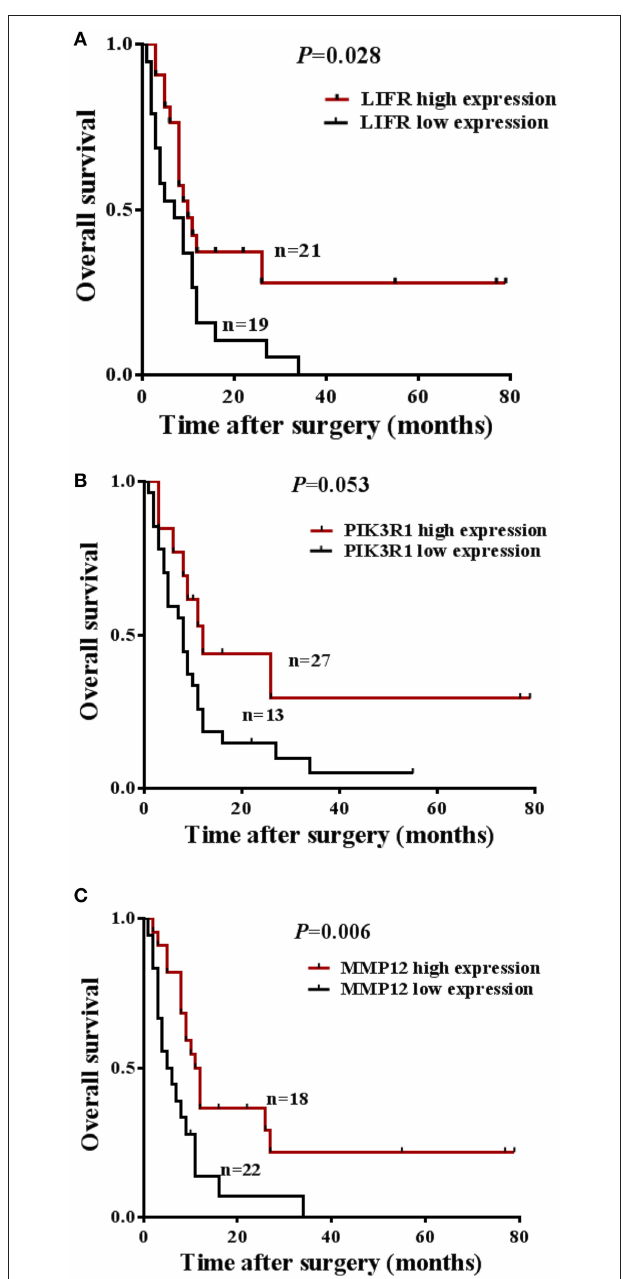
FIGURE 4 | Prognostic significance of LIFR , PIK3R1, and MMP12 expression for GBC patients. (A) Kaplan-Meier curve for the overall survival (OS) of patients with low vs. high expression of LIFR (median OS 7.0 vs. 10.0 months, respectively; log-rank test, P = 0.028). (B) Kaplan-Meier curve for the OS of patients with low vs. high expression of PIK3R1 (median OS 8.0 vs. 12.0 months, respectively; log-rank test, P = 0.053). (C) Kaplan-Meier curve for the OS of patients with low vs. high expression of MMP12 (median OS 5.5 vs. 11.5 months, respectively; log-rank test, P = 0.006).